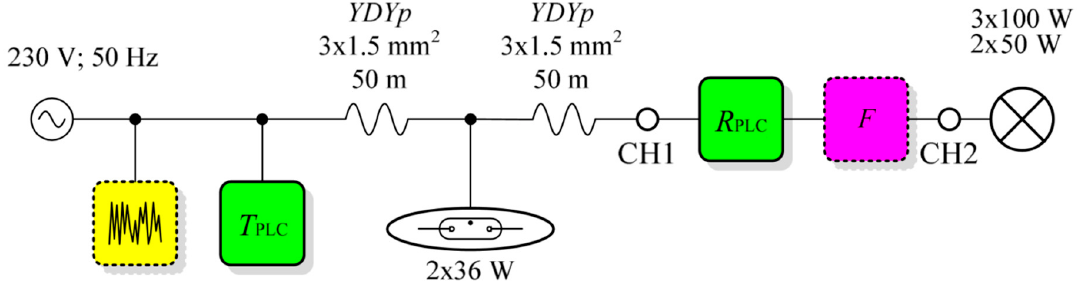
Figure 14. Connection schematic of the model without an EMI filter and with an additional receiver connected in the middle of the line (without the F filter)—Variant 4.